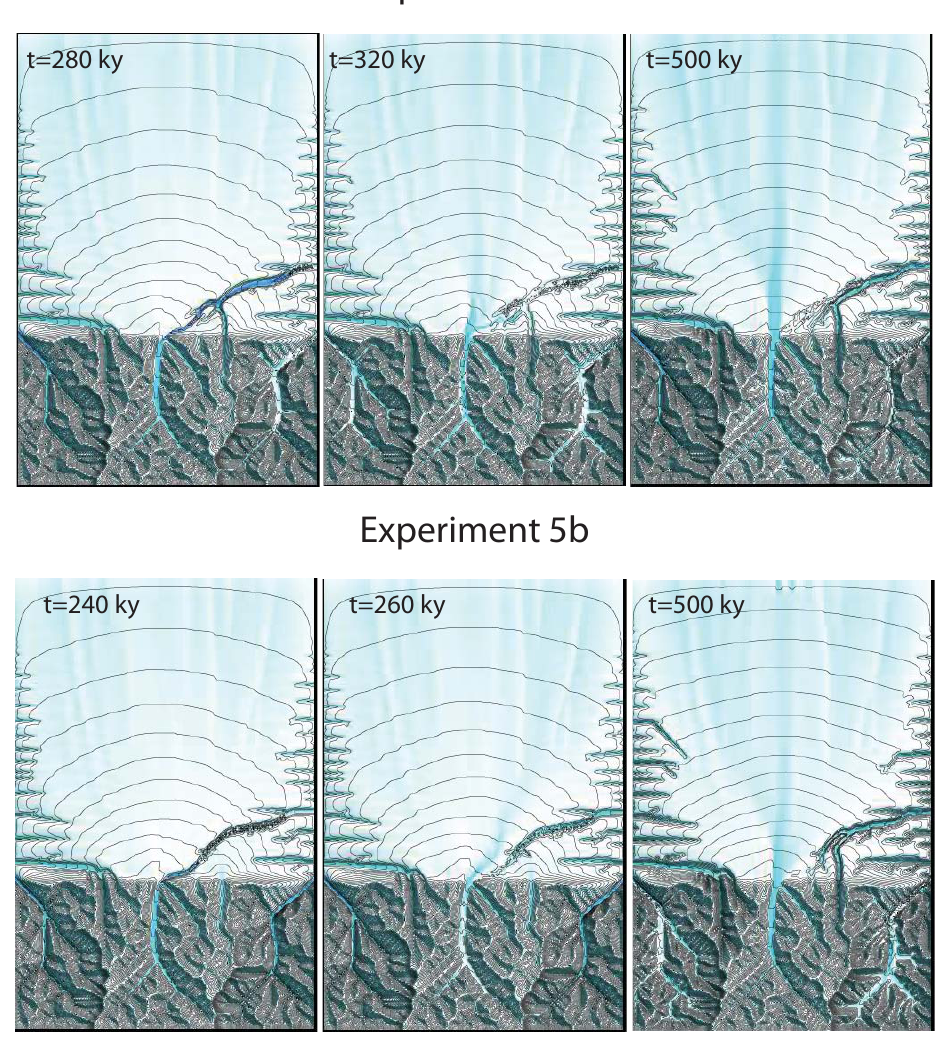
Figure 10. Tilting experiments 5a (0.13 ◦ tilt) and 5b (0.4 ◦ tilt). Connection with the headward incising stream occurs (at 280 and 240kyr re- spectively) but model instabilities in the channel, interpreted as deposition, induce overflowing (at 320 and 260kyr respectively). Distributive flow over the megafan resumes and lasts until the end of the